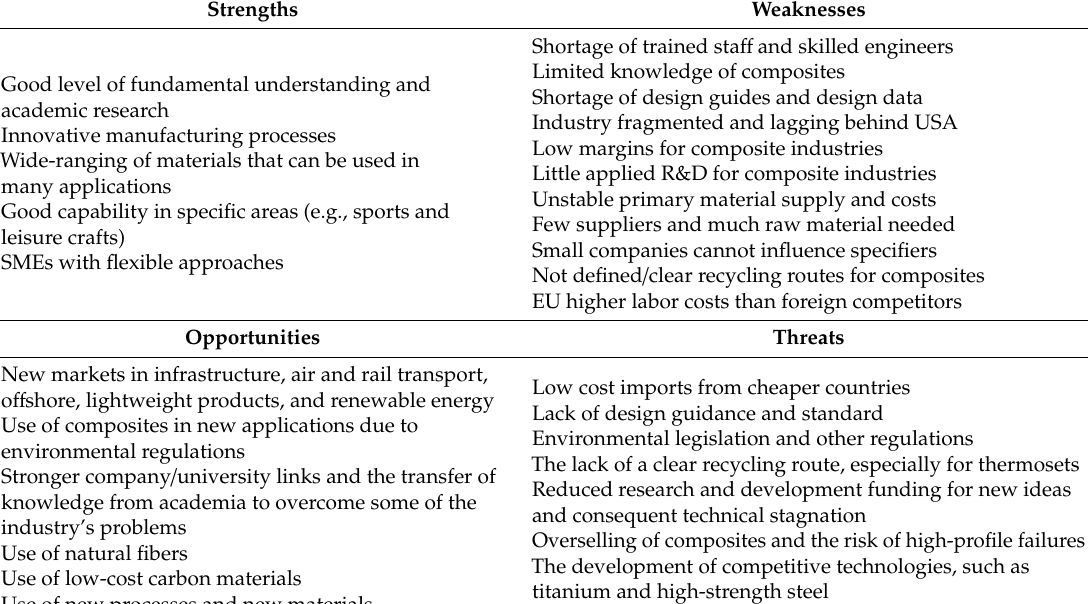
Table 2. SWOT analysis